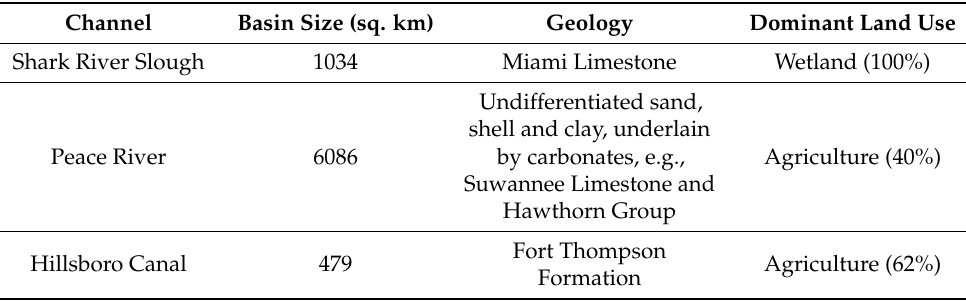
Table 1. General basin characteristics of the